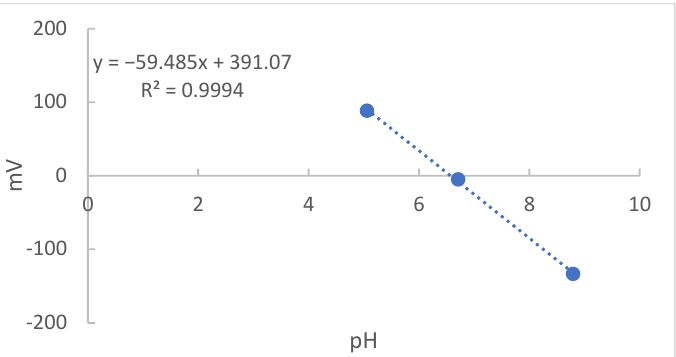
Figure 8. The pH values versus mV obtained for the different solutions from electrode C.